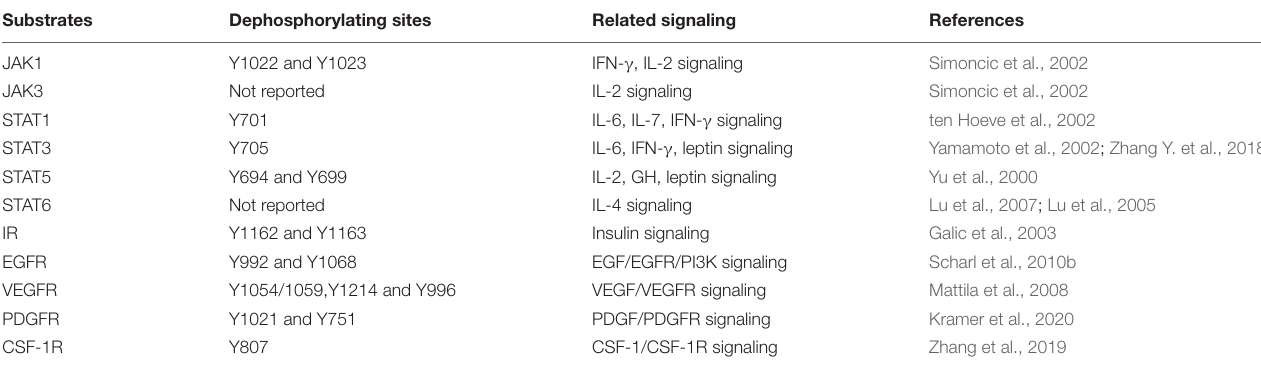
FIGURE 2 | Main substrates of TCPTP (modified according to reference Bourdeau et al., 2005). Upon ligand binding, the receptor of IL-2, IL-4, IL-6, IFN- γ , GH, and leptin associated JAKs and STATs become activated. TCPTP can dephosphorylate JAK1 and JAK3, as well as STAT1, STAT3, STAT5, and STAT6 (molecules in blue), whereas it is not identical in different cytokine signaling according to summary of existing literatures. Besides, TCPTP is capable of regulating diverse signaling pathways by dephosphorylating various RTKs (e.g., IR, EGFR, VEGFR, PDGFR, and CSF-1R). TCPTP, T cell protein tyrosine phosphatase; IL-6, interleukin-6; IL-6R, interleukin-6 receptor; IFN- γ , interferon- γ ; IFNGR, interferon- γ receptor; Leptin R, leptin receptor; IL-2, interleukin-2; IL-2R, interleukin-2 receptor; GH, growth hormone; GHR, growth hormone receptor; IL-4, interleukin-4; IL-4R, interleukin-4 receptor; JAK, Janus activated kinase; STAT, signal transducer and activator of transcription; RTKs, receptor tyrosine kinases; IR, insulin receptor; EGF, epidermal growth factor; EGFR, epidermal growth factor receptor; VEGF, vascular endothelial growth factor; VEGFR, vascular endothelial growth factor receptor; PDGF, platelet-derived growth factor; PDGFR, platelet-derived growth factor receptor; CSF-1, colony-stimulating factor-1; CSF-1R, colony-stimulating factor-1 receptor. TABLE 1 | Main substrates and dephosphorylating sites of